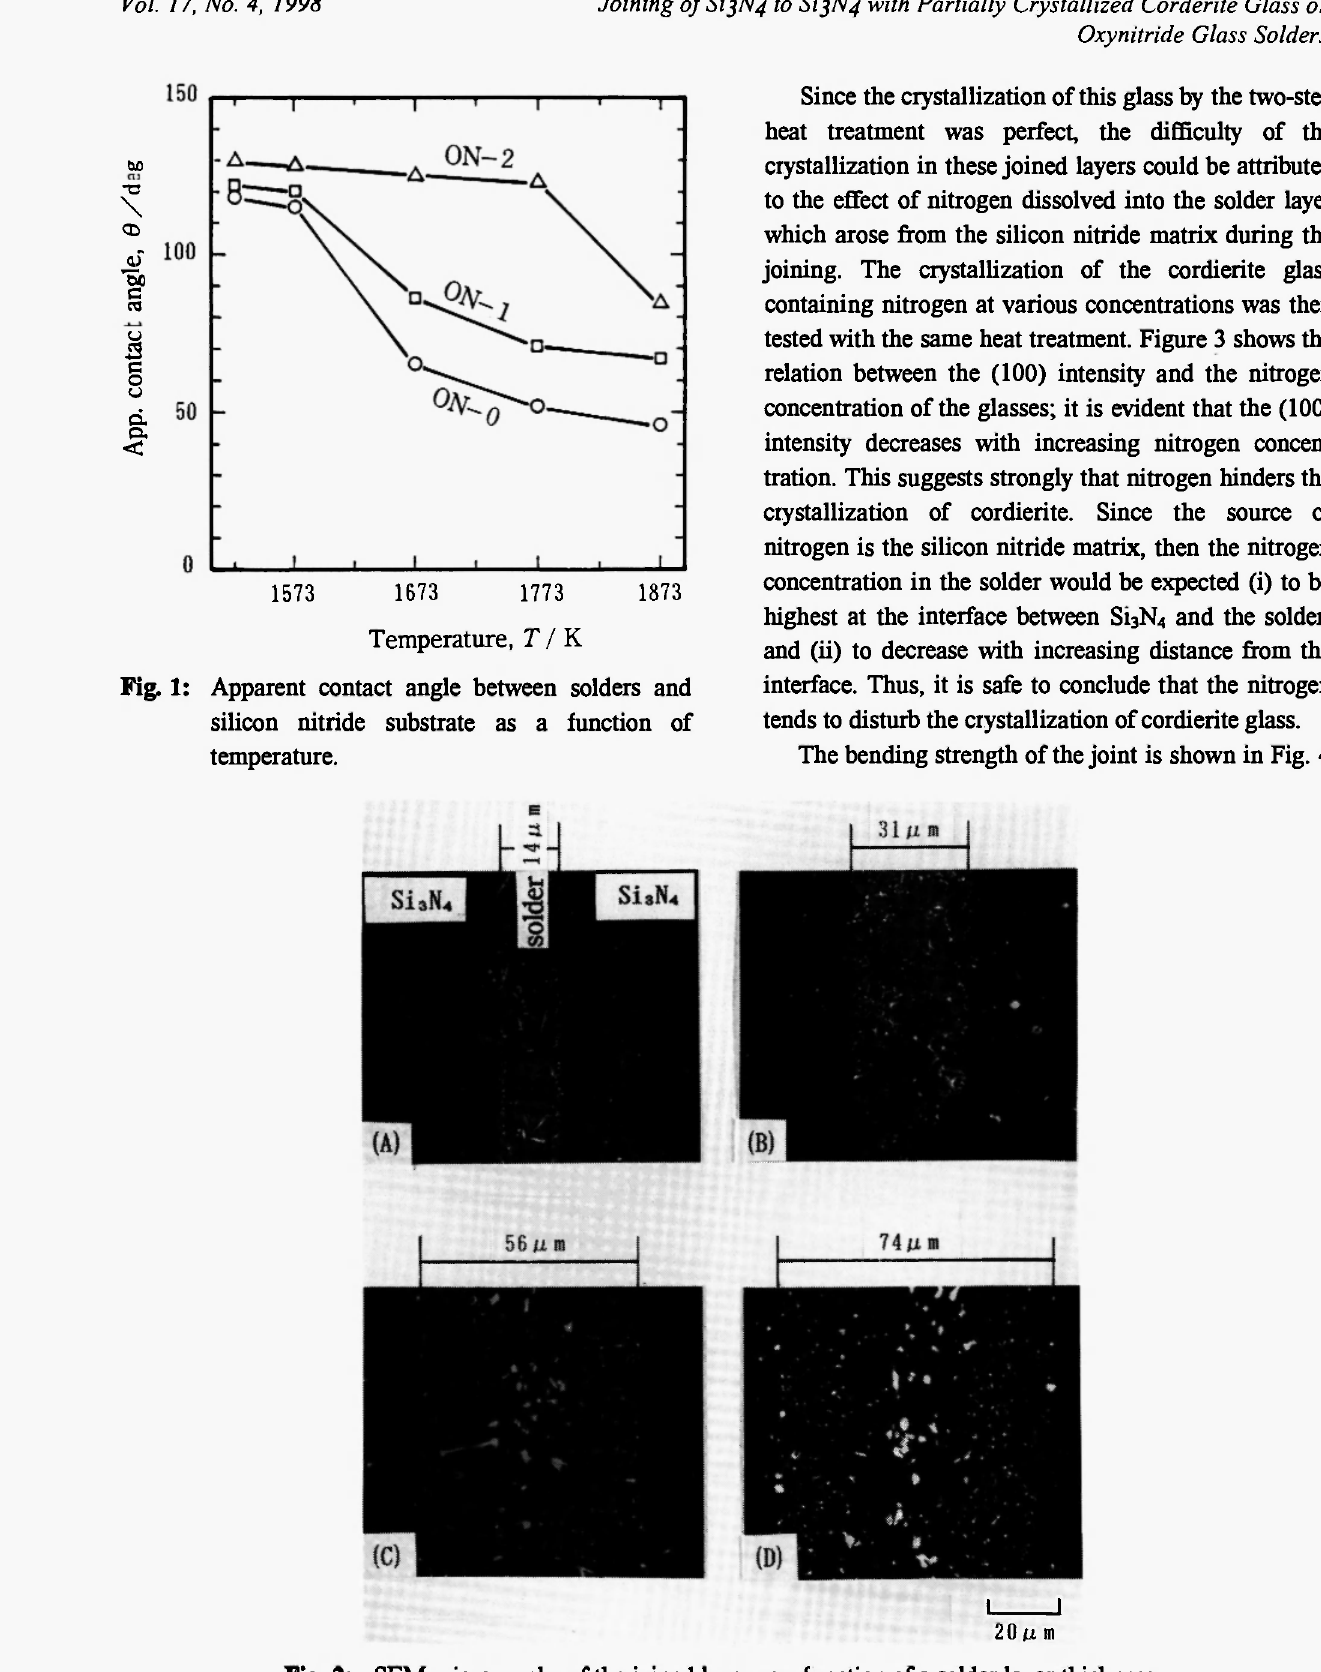
Fig. 2: SEM micrographs of the joined layer as a function of a solder layer